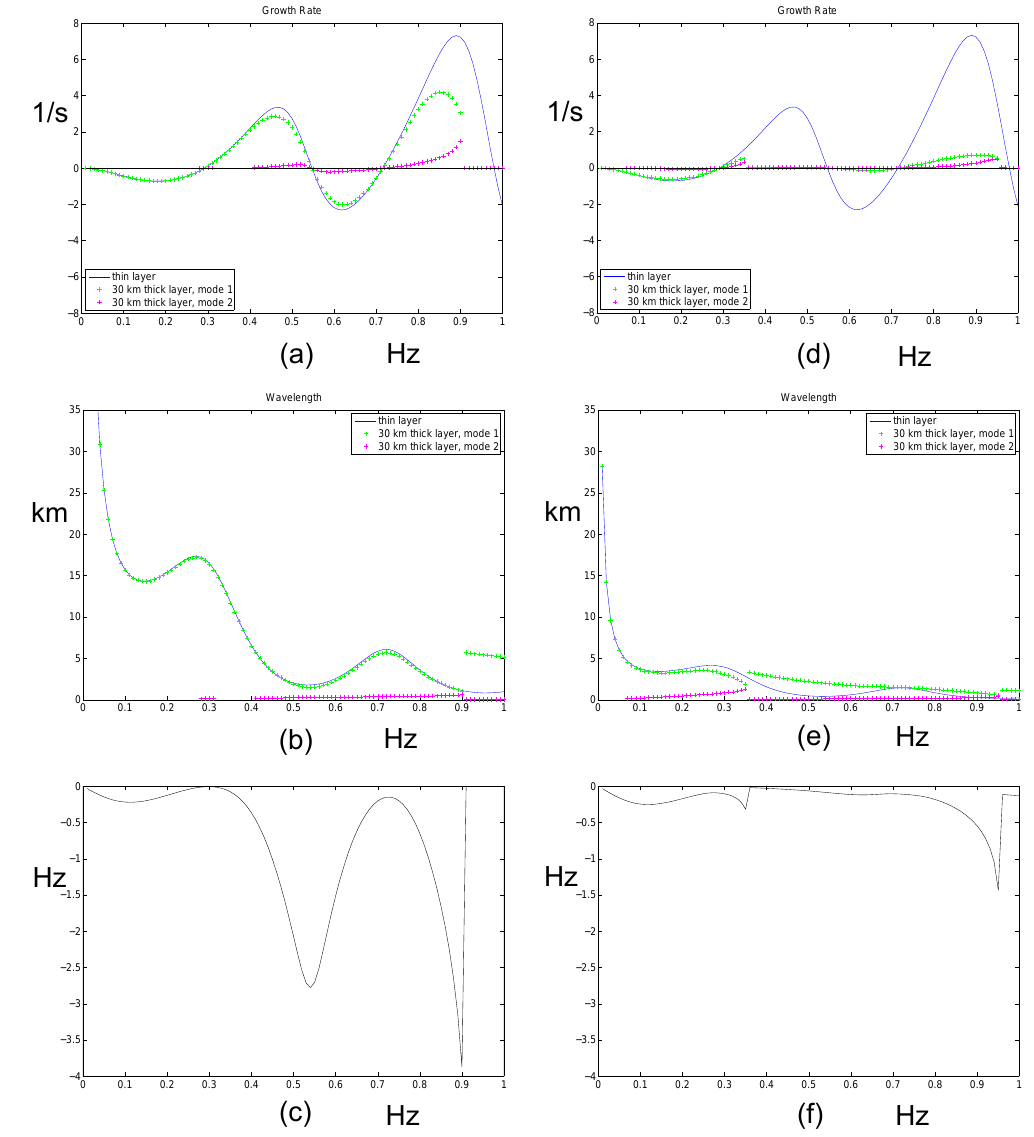
Fig. 9. Comparison of results for E 0 pointing perpendicular to the wavevector (panels a–c ), and for E 0 pointing along the wavevector (panels d–f ). In all panels E 0 = 250mVm − 1 . Growth rate, wavelength, and frequency in the earth-fixed frame, are plotted versus frequency in the frame moving with the E 0 × B velocity, for a 120km altitude layer. The green (purple) lines show results for the mode with the largest (second largest) growth rate for a 30km thick layer. The blue lines show results for a thin auroral layer of the same integrated conductivity. The results for the frequency in the earth-fixed frame (black lines) are shown only for the mode with the largest growth rate when the layer is 30km thick (i.e., for the green lines). The integrated Pedersen and Hall conductivities are 2.27mhos and 9.05mhos, respectively, which corresponds to a 30km thick layer with an electron density of 10 11 m − 3